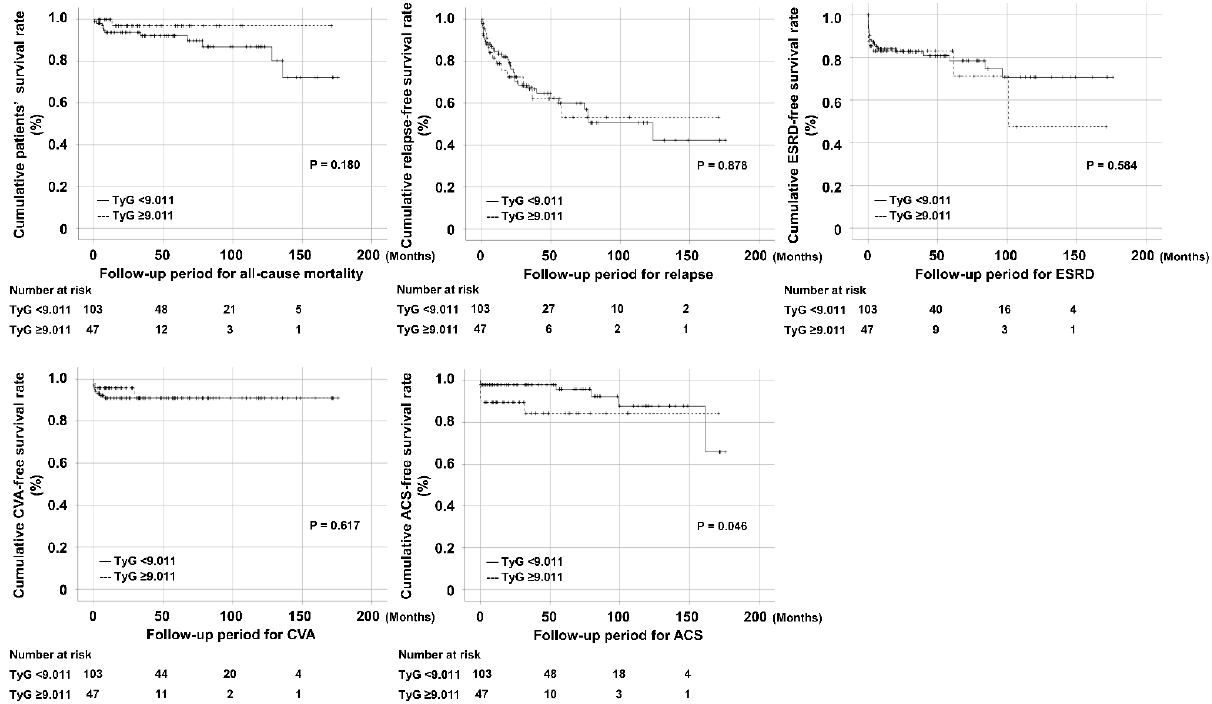
Figure 1. Comparison of cumulative survival rates according to the TyG index. Patients were di- vided into two groups according to the highest tertile of the TyG index ( ≥ 9.011). Only the occurrence of ACS significantly differed between AAV patients with a TyG index ≥ 9.011 and those with a TyG index < 9.011 among the five poor prognoses. TyG, triglyceride-glucose; ACS, acute coronary syndrome; AAV, ANCA-associated vasculitis; ANCA, antineutrophil cytoplasmic antibody; ESKD, end-stage renal disease; CVA, cerebrovascular accident.